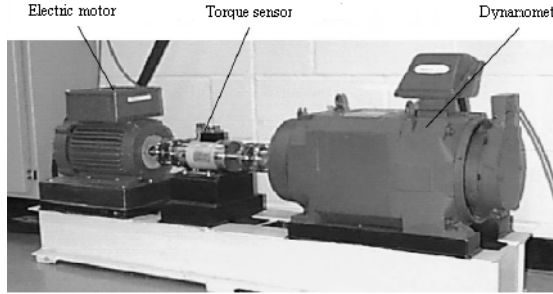
Figure 13. Balling bearing fault experiment bench.